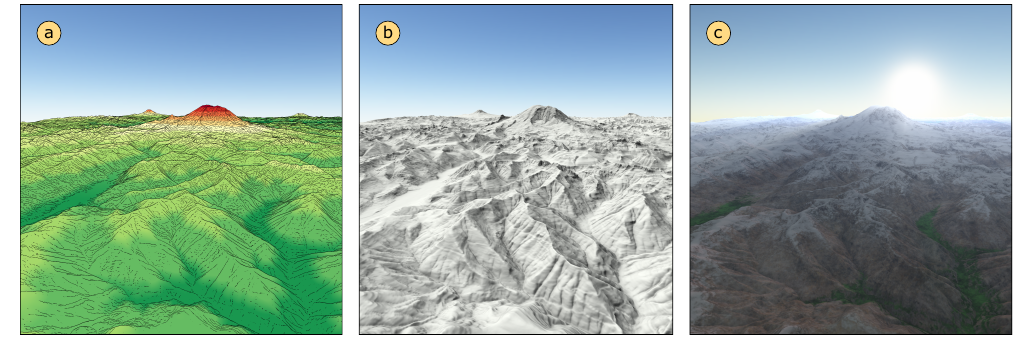
Figure 16. Visualizing terrain using different render methods and parameters: In ( a ), edge enhancement combined with elevation-coloring is used; in ( b ), a global illumination model is applied, and, in ( c ), volumetric lighting is